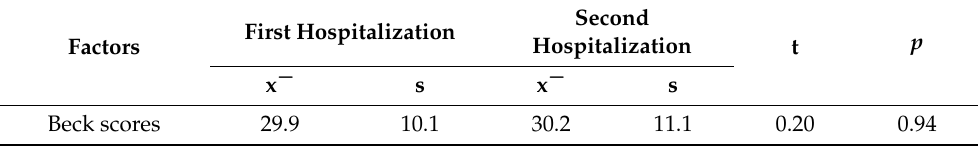
Table 3. Severity of depression on the Beck